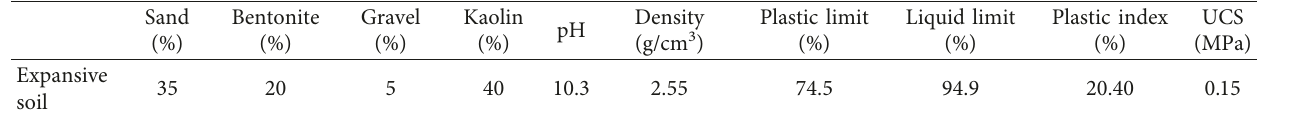
Table 2: Properties of expansive